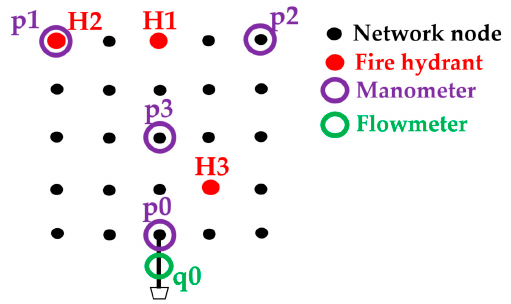
Figure 2. Location of open fire hydrants (H1, H2, and H3) and monitoring points: q0; p0; p1; p2; and p3.